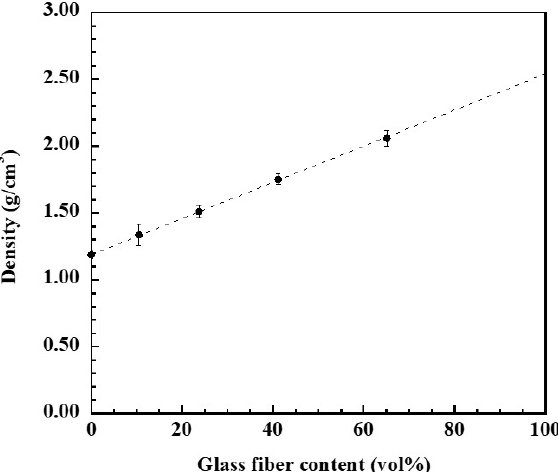
Figure 2. ( ) Experimental density, (-----) theoretical density of GF-reinforced poly(BA-a) composites at various GF contents.